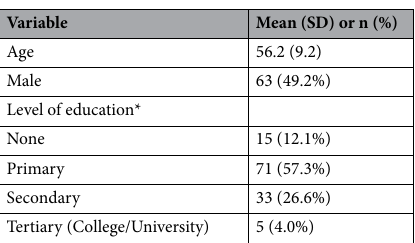
Table 1. Demographic characteristics of the study participants. *n =